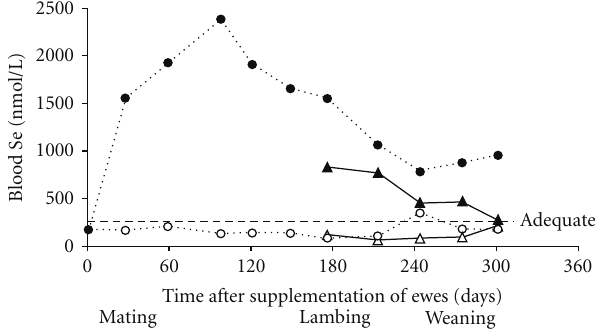
Figure 3: E ff ect of no treatment ( (cid:2) ) or subcutaneous injection of 3mg ( (cid:2) ) or 6mg ( (cid:3) ) microencapsulated vitamin B 12 (0.15 and 0.30mg/kg LW) administered to Co-deficient lambs at docking time on liveweight [22].